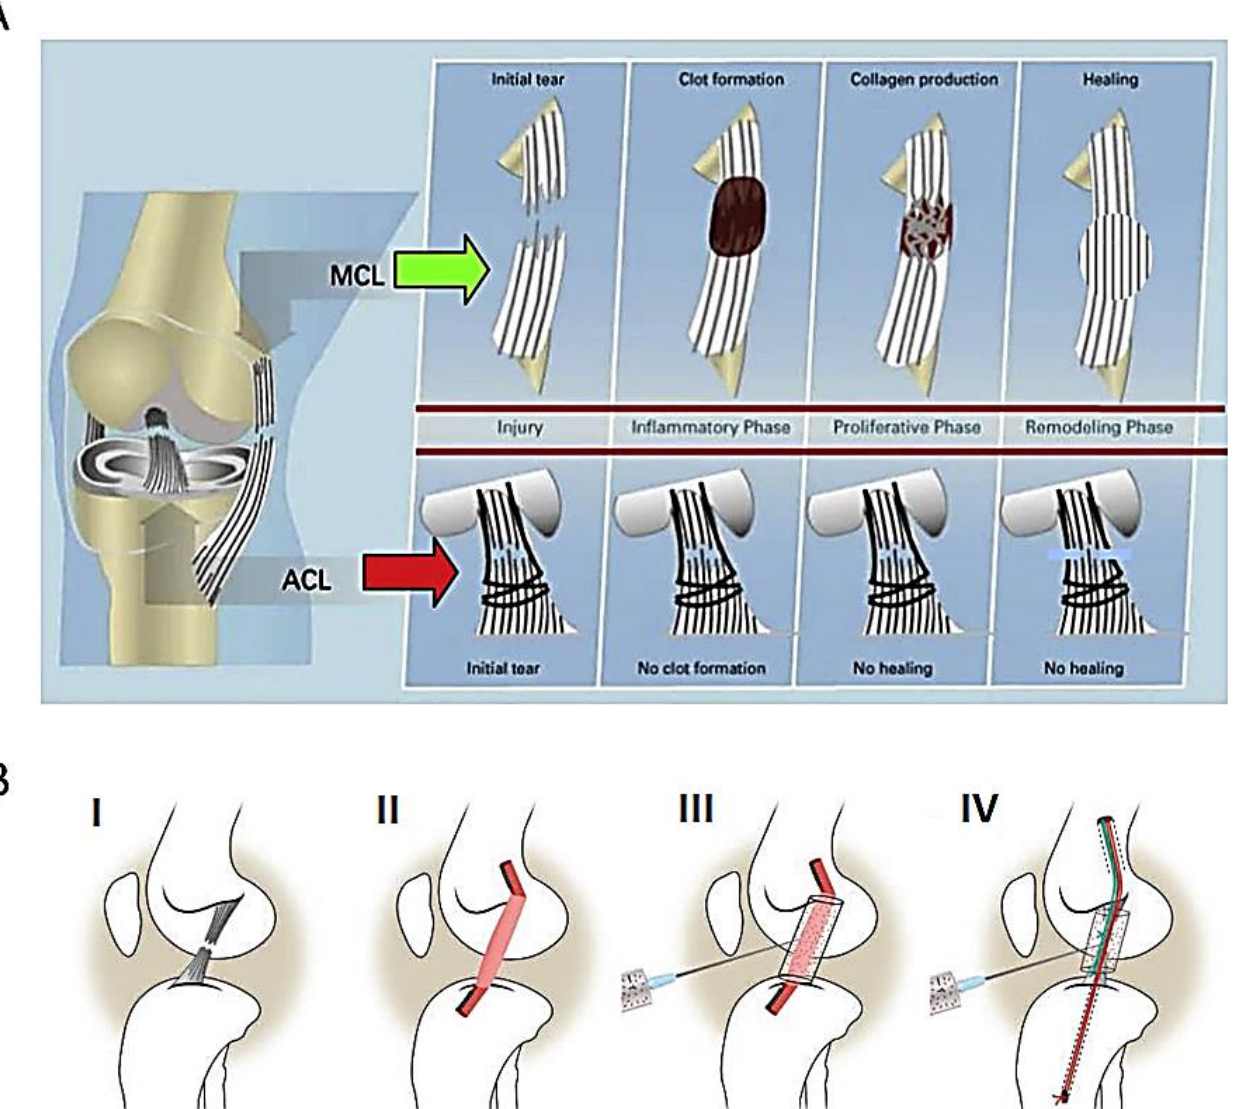
Figure 6. ( A ) New hypothesis of ACL healing failure explained by Murray et al. [78]. After an